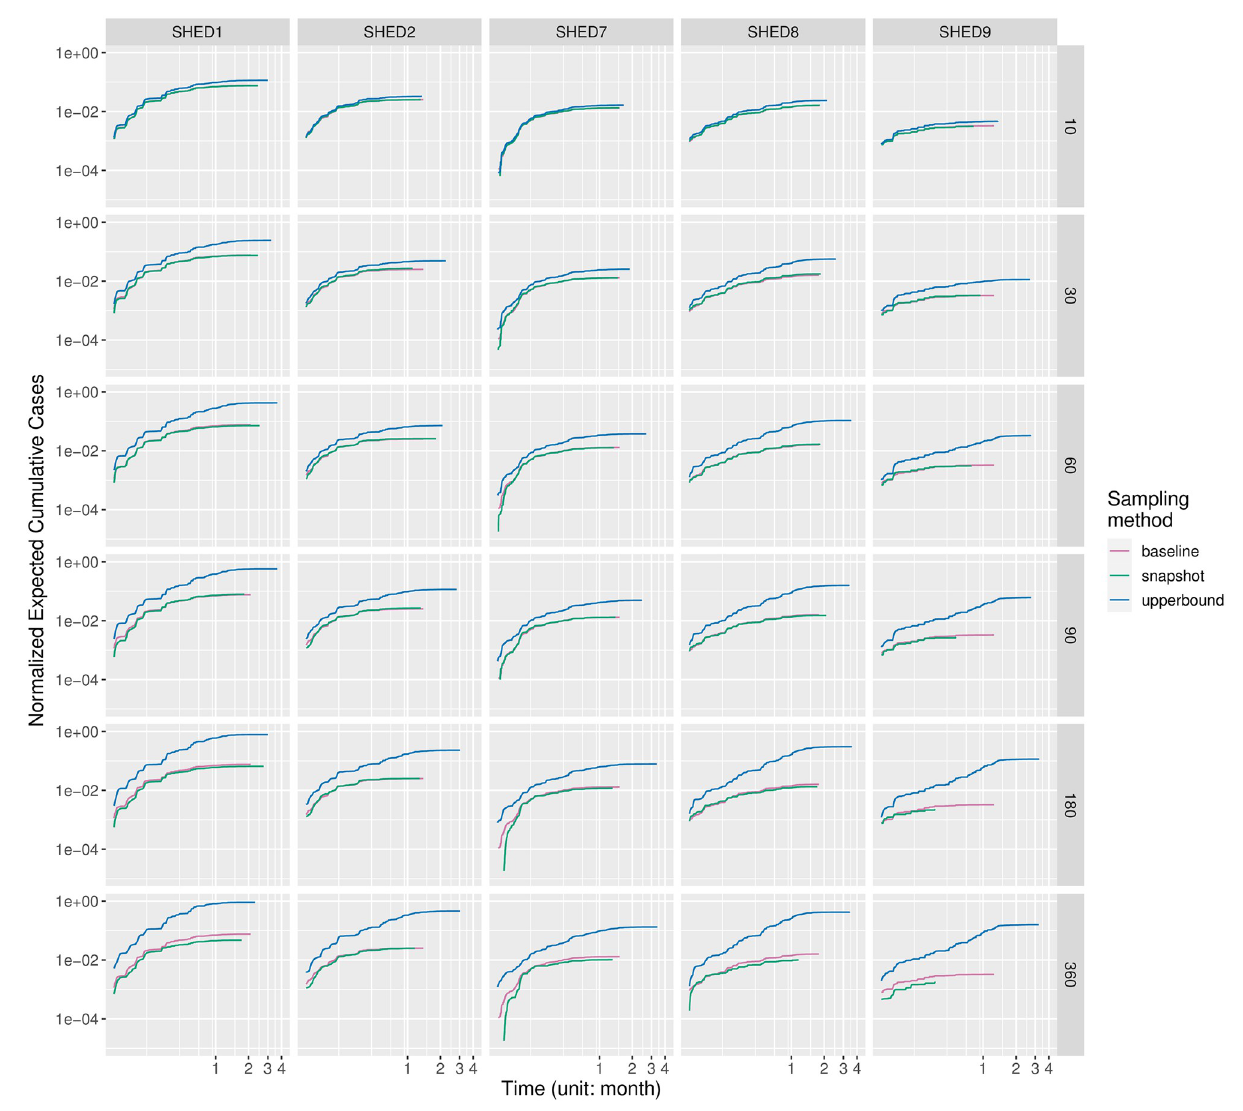
Fig 3. Outbreak timing of